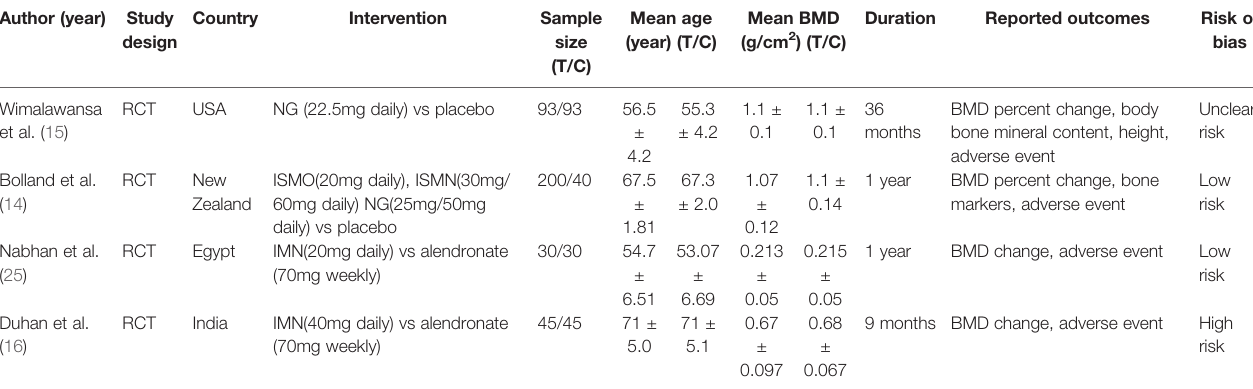
TABLE 2 | Characteristics of the four included randomized controlled studies.